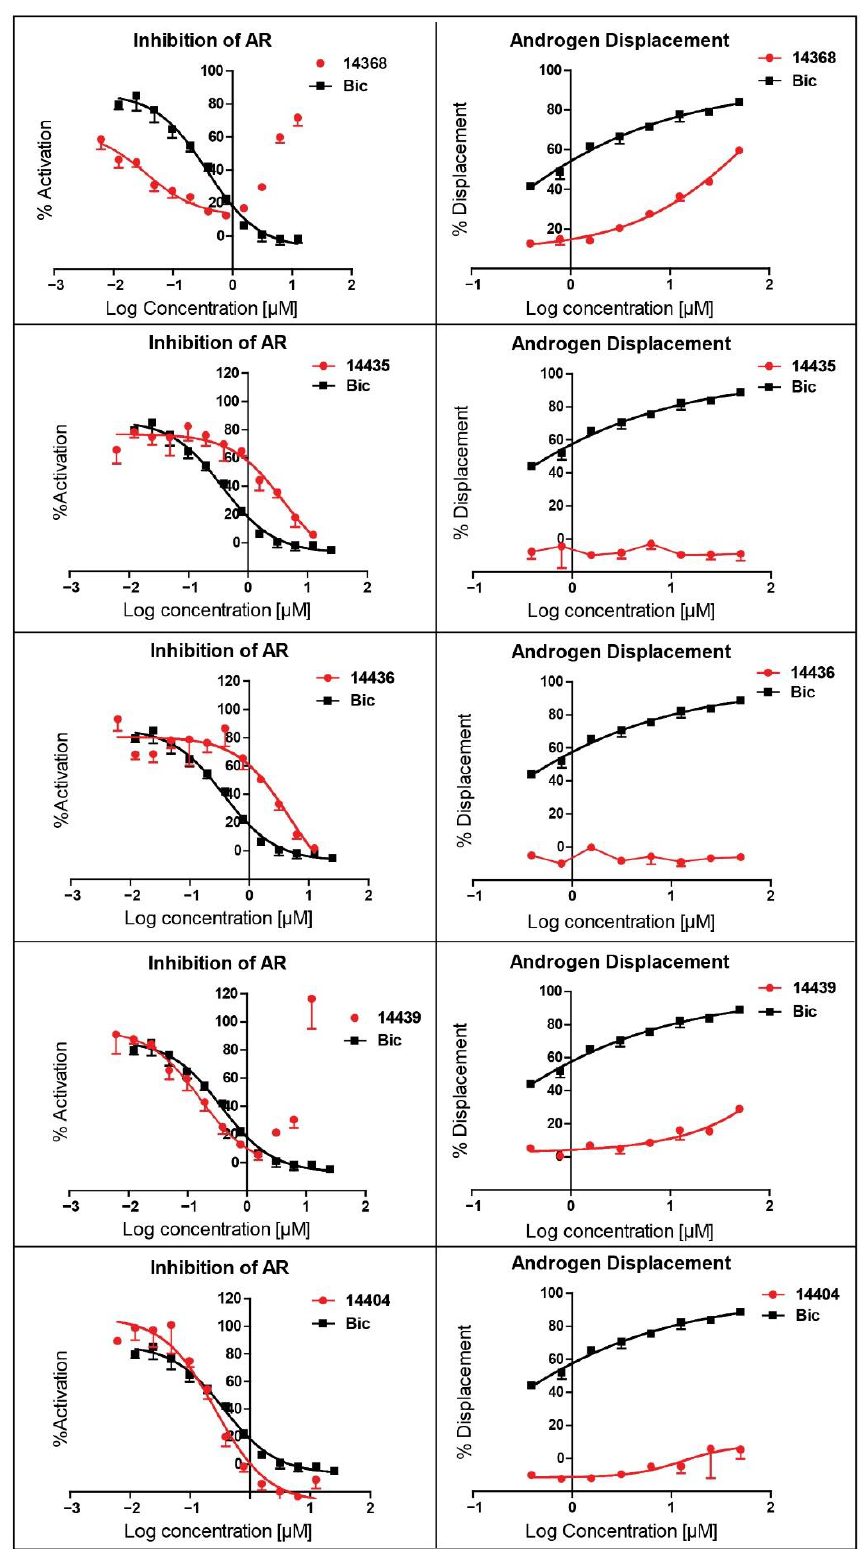
Figure 5. Left panel: dose-response curves of AR transcriptional inhibition by VPC14368, VPC14449, VPC14404, VPC14439, VPC14435 and bicalutamide (Bic) using eGFP AR transcriptional assay in the presence of 0.1 nM R1881. Right panel: dose-response curves of androgen displacement VPC14368, VPC14449, VPC14404, VPC14439 and VPC14435 using Polar Screen Androgen Receptor Competitor Green Assay